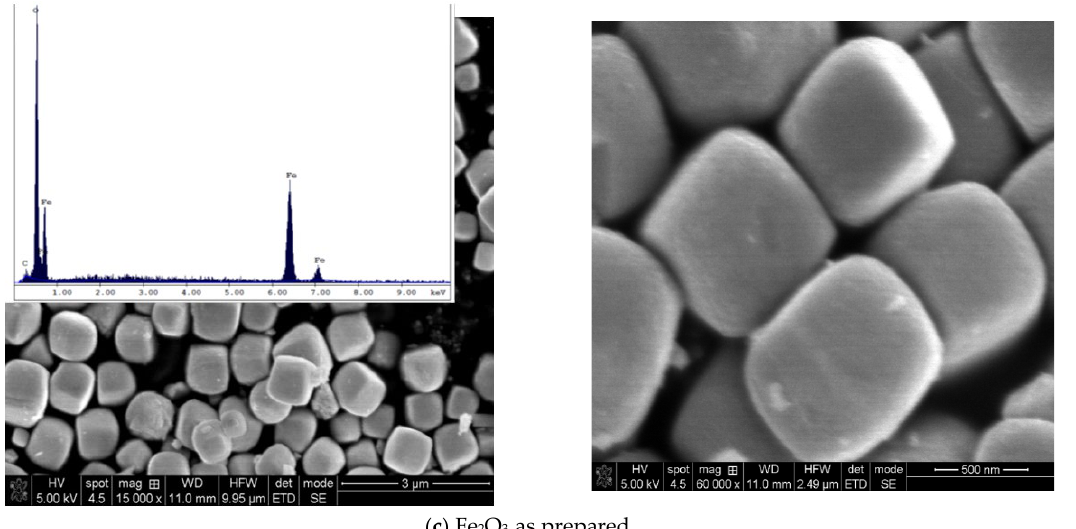
Figure 1. SEM images and EDAX spectra: ( a ) TiR as prepared, ( b ) FeTiR, ( c ) Fe 2 O 3 nanocubes. Figure 1c shows well-defined Fe 2 O 3 nanocubes with a narrow size distribution around 700–800 nm and smooth surfaces. Ma et al. [24] reported the obtaining of Fe 2 O 3 microcubes and small nanoparticles depending on the hydrothermal treatment parame- ters.